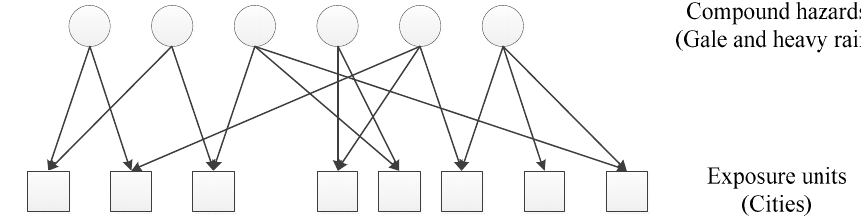
Figure 5. Structure of the disaster network based on bipartite network.